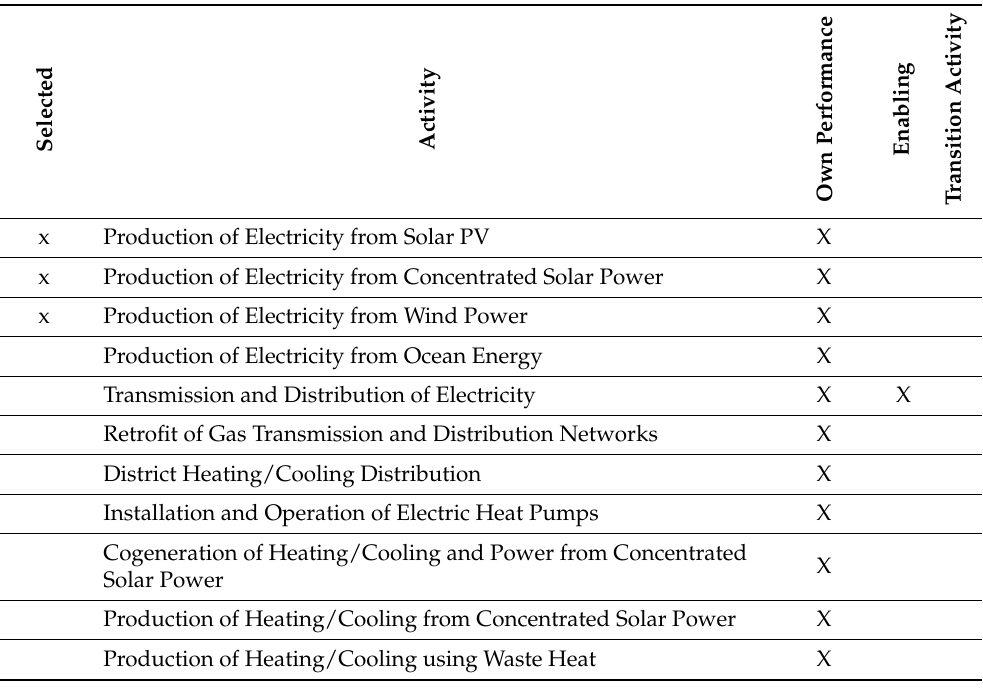
Table 1. Climate change mitigation activities related to the NACE macro-sector electricity, gas, steam and air conditioning supply and without transitory aspects. From: